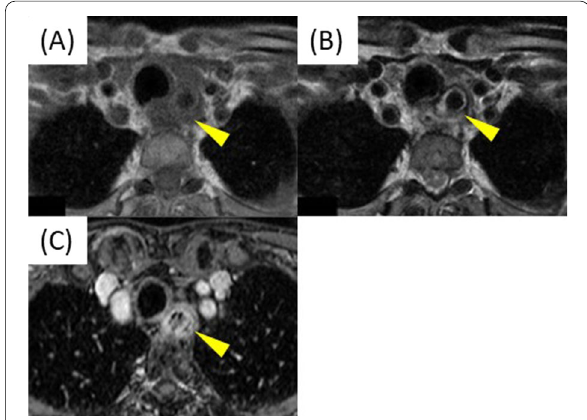
Fig. 3 Contrast-enhanced MRI. Plain T1-weighted imaging ( A ), and plain T2 ( B ). Contrast-enhanced T1 ( C ) showed a non-signal line in the mediastinal foreign